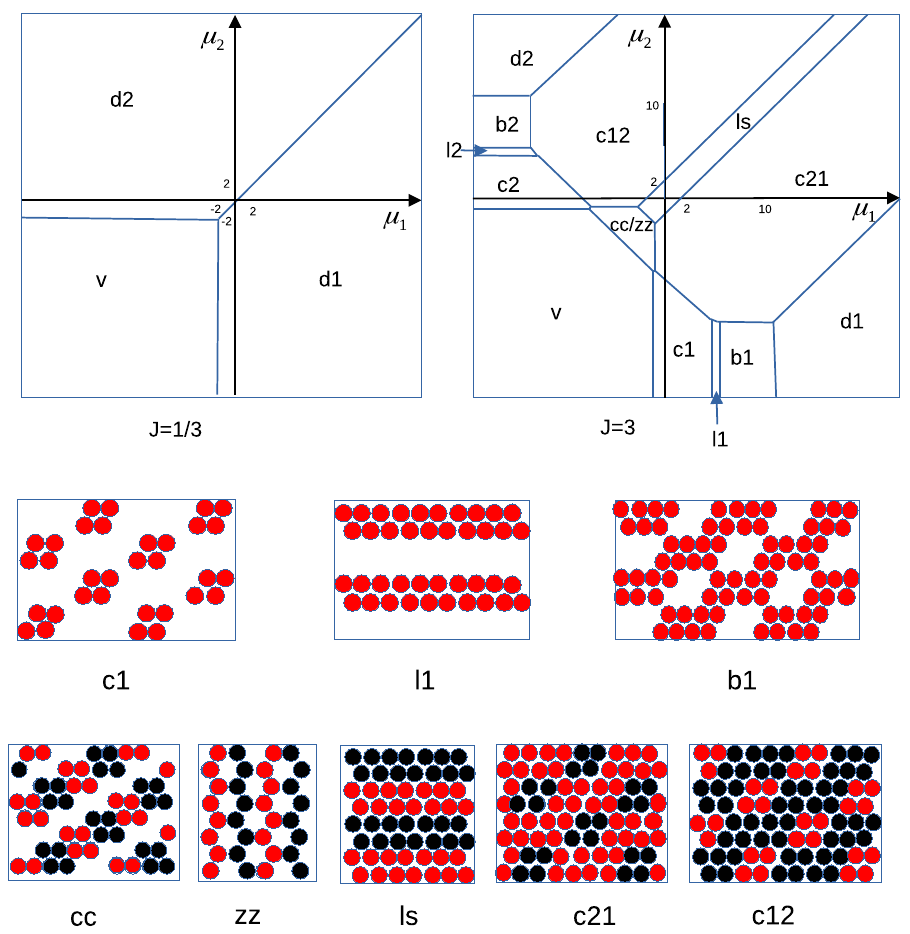
Figure 5. Ground state of the model for the binary mixture with the interactions given in (1) and (2). The chemical potential µ i of the species i is in units of the nearest-neighbor interaction J 1 . We compared the GS for J = J 2 / J 1 = 1/3 and J = 3. The periodic structures are shown below the ground states. c2, l2, b2 are the same as c1, l1, b1 with the particles of the second species replacing the particles of the first one. d1 and d2 denote the dense phases with all lattice cells occupied by the first and the second component, respectively, and v denotes the vacuum. cc/zz denotes the stability region of the coexisting cc and zz phases. Red and black circles represent the first- and the second-component particles, respectively, and empty cells are not